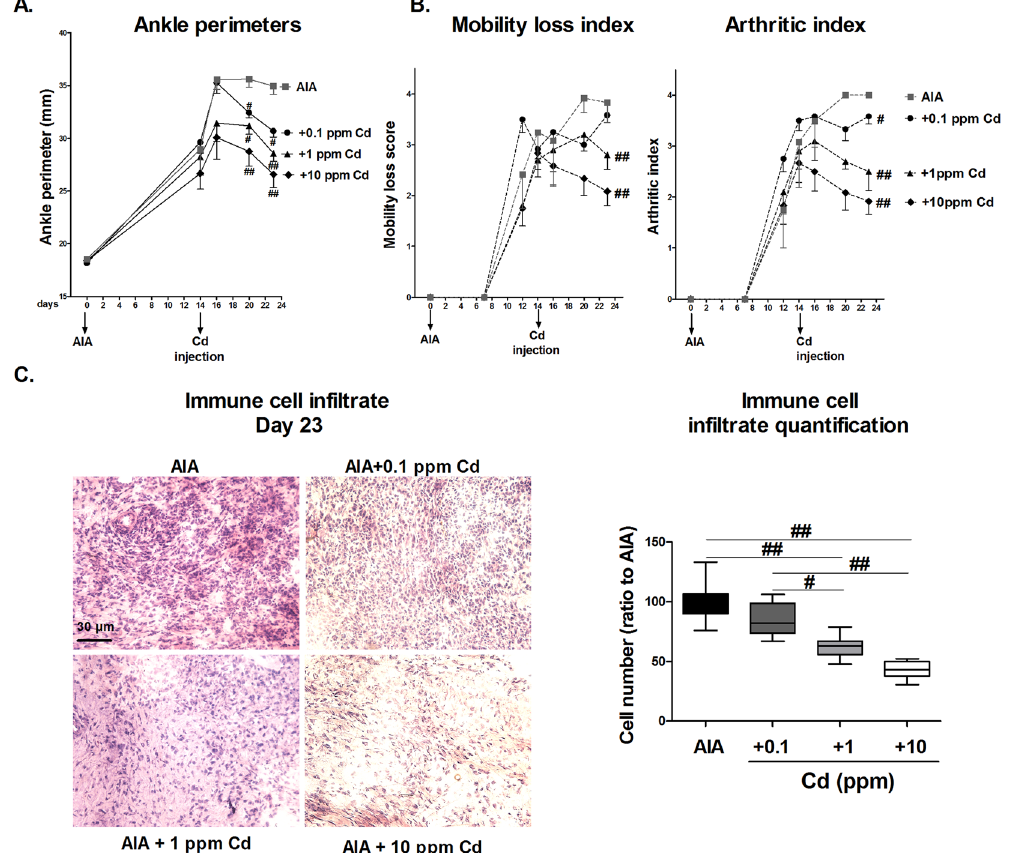
Figure 3. Cd intra-articular injection improves clinical scores and reduces inflammation in AIA rats. ( A ) Ankle perimeters of rat hind paws in function of time. Day 0: AIA induction; day 14: Cd intra-articular injection. ( B ) Clinical scores of AIA; Left panel: mobility loss index from 0 = normal use of paws to 4 = complete loss of paw support; right panel: arthritic index from 0 = no swelling or erythema to 4 = excess oedema with joint rigidity. ( C ) H&E staining and measurement of immune cell infiltrate plus synoviocytes on joint pannus layers. Data are the mean of two independent measures on 6 animals per group, excepting the AIA plus Cd-1 ppm group, counting 5 animals. Data are represented as mean ± SEM; # p < 0.05, ## p <